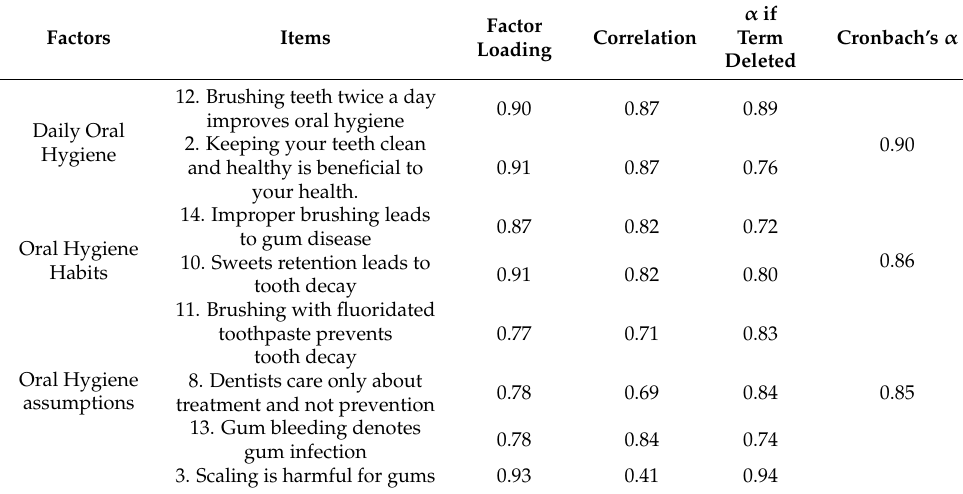
Table 4. Result of EFA for attitude-based questions.